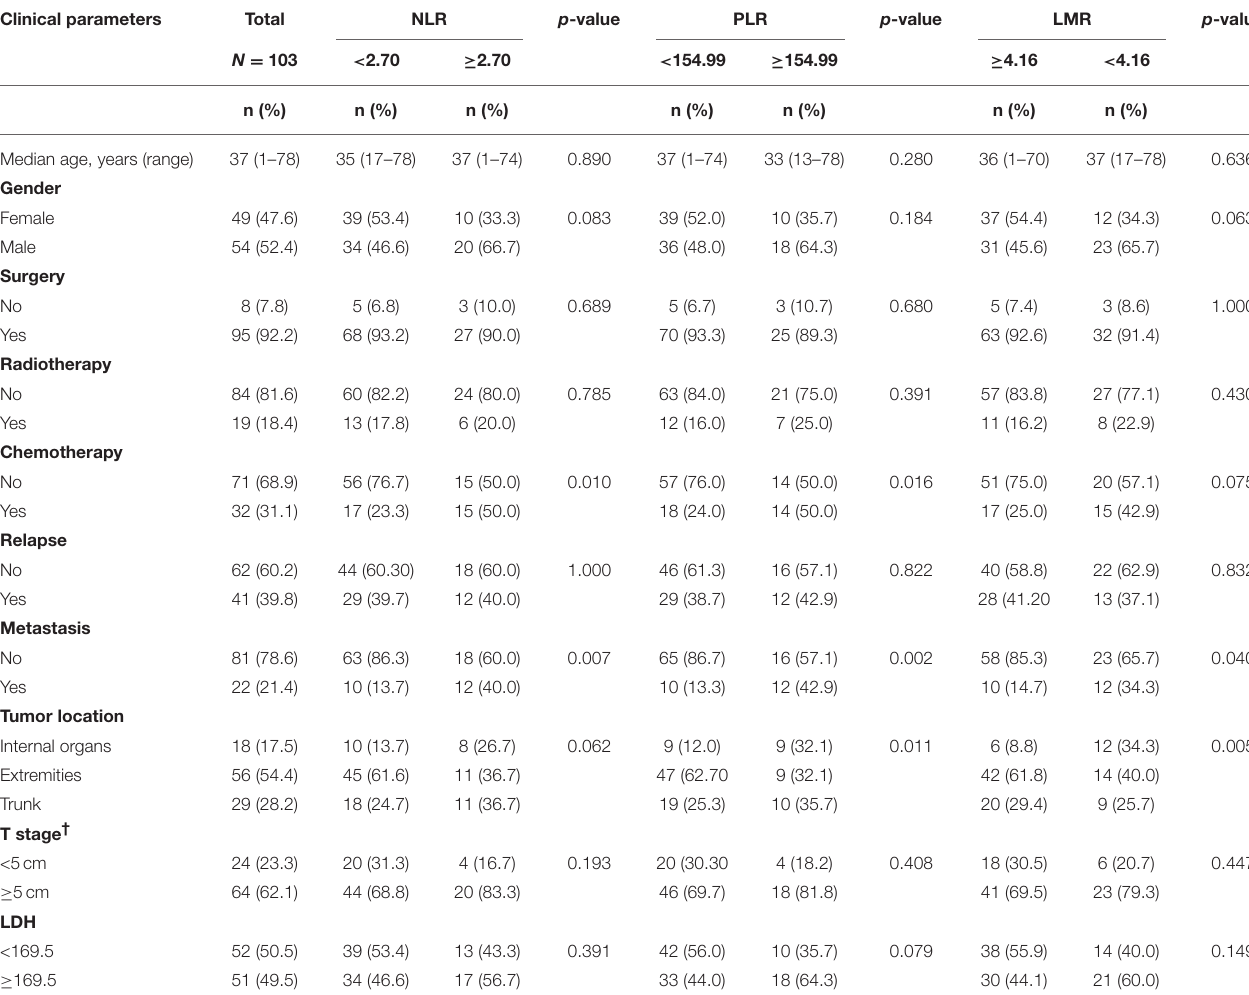
TABLE 1 | Baseline characteristics of the patients with synovial sarcoma. Clinical